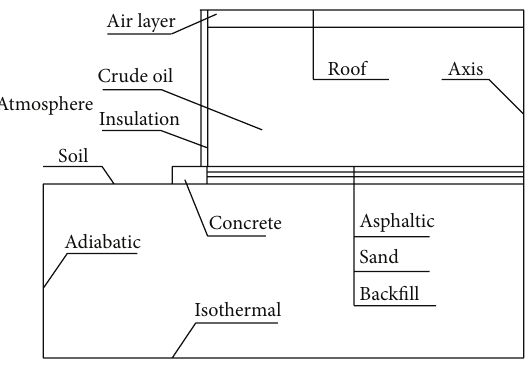
Figure 1: Physical